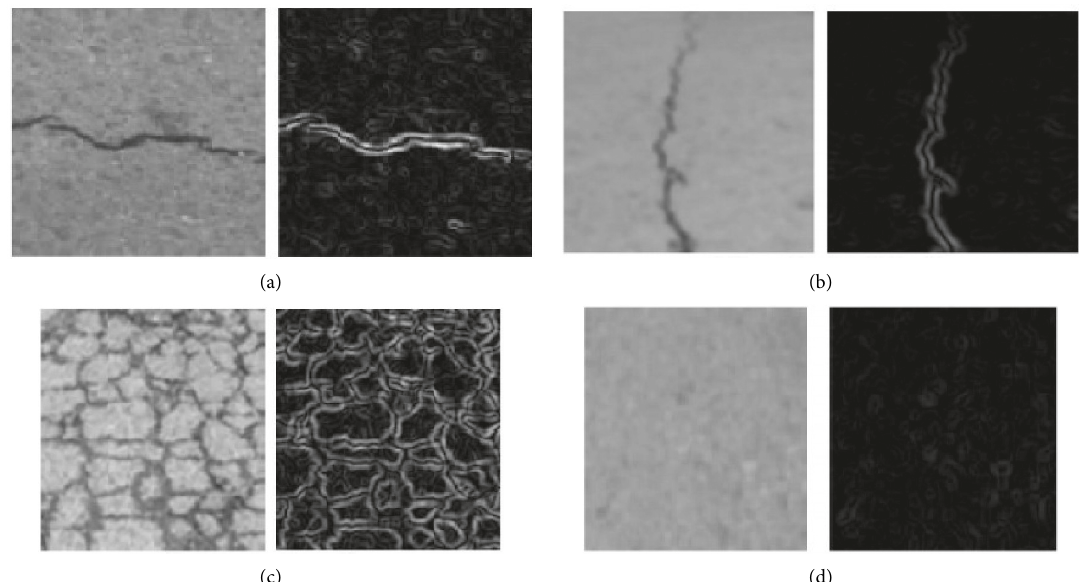
Figure 5: Images and SF response for various forms of cracks [64]. (a) Transverse crack. (b) Longitudinal crack. (c) Alligator crack. (d) No